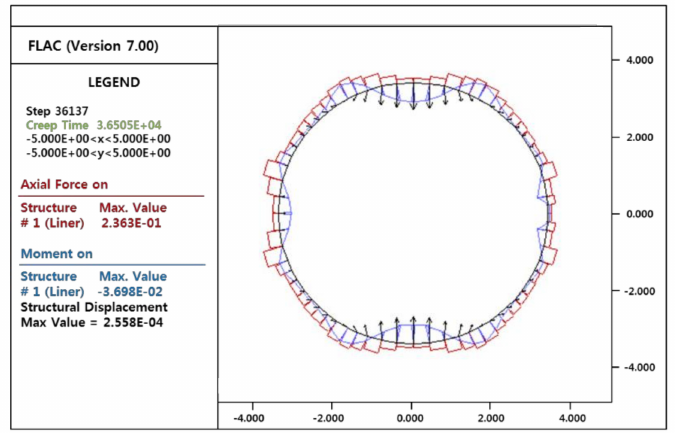
Figure 10. Maximum lining forces on shaft